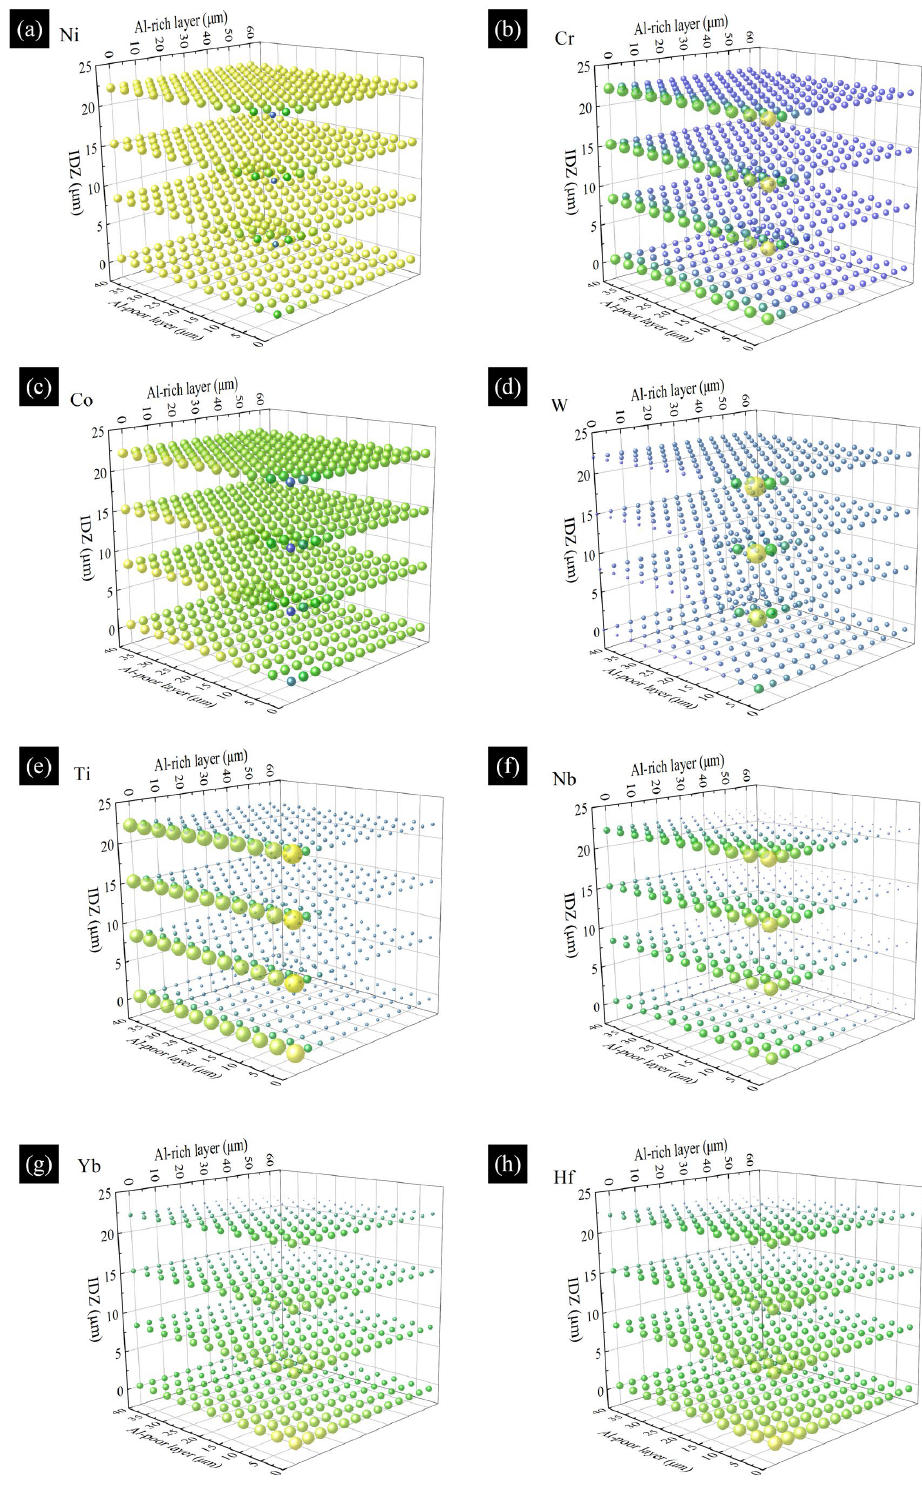
Figure 3. Relative values of XRF intensity as elements at different thickness combinations. ( a–h ) corresponds to Ni, Cr, Co, W, Ti, Nb, Yb, and Hf elements.